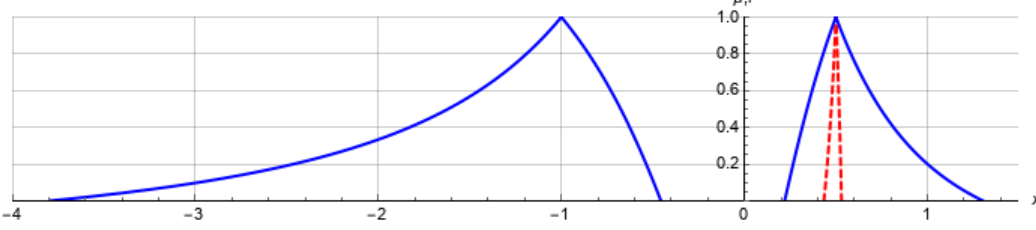
Figure 8. All solutions (roots) calculated with multidimensional fuzzy arithmetic (continuous line) and with the standard approach using Newton’s method (dashed